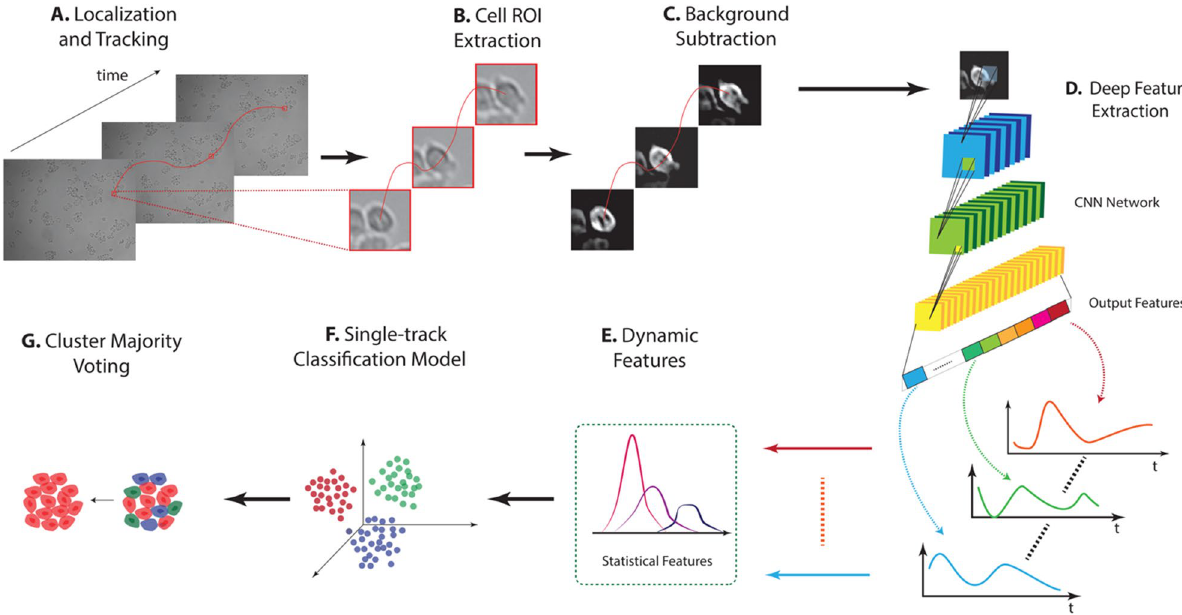
Figure 6. The figure depicts an overview of the method. ( A ) Cells are located and tracked. ( B ) Cell centered ROIs are extracted. ( C ) Background suppression is applied to the ROIs. ( D ) Features are extracted from the processed ROIs using a pretrained Deep Neural Network. ( E ) Starting from features signals, statistics are extracted in order to catch the dynamic of the phenomenon. ( F ) Using the statistics as features, machine learning model is constructed in order to have predictions at single cell level. ( G ) Cluster-based majority voting is finally exploited to summarize the cluster